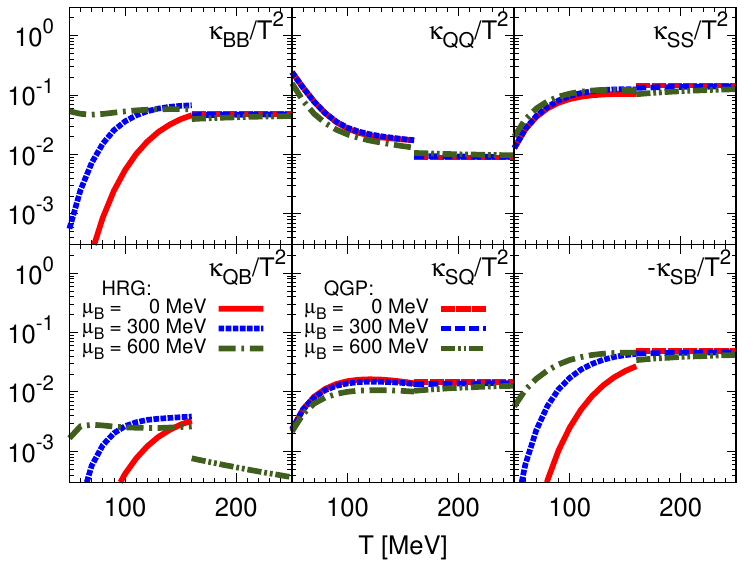
Figure 1. Evaluated diffusion coefficients κ qq (cid:48) / T 2 of a system with 19 hadronic species plotted for temperatures below 160 MeV and for a conformal system of massless quarks and gluons calculated for temperatures larger than 160